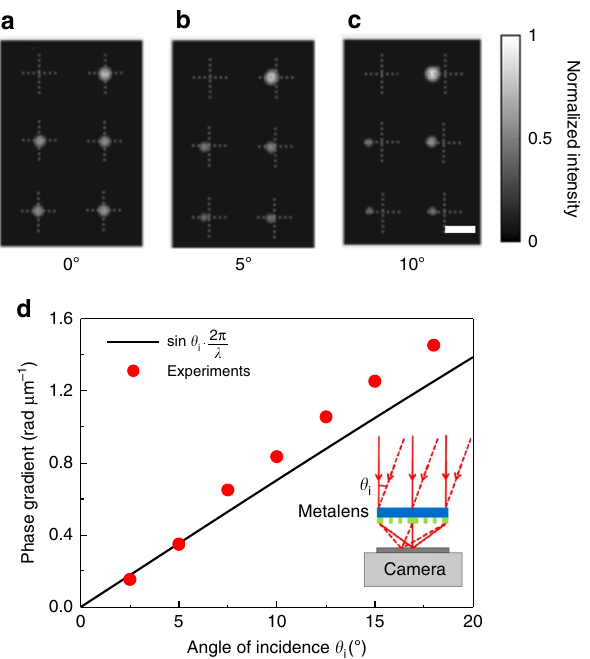
Fig. 5 Experimental veri fi cation of wavefront detection by the metalens array. a – c Focal intensity distributions within one pixel of the metalens array for incident angles of 0°, 5°, and 10°, respectively. For clarity, dashed crosses are added to mark the central position of every metalens. Scale bar: 10 μ m. d Phase gradient versus angle of incidence. Measurements are shown as red dots, theory by the black straight